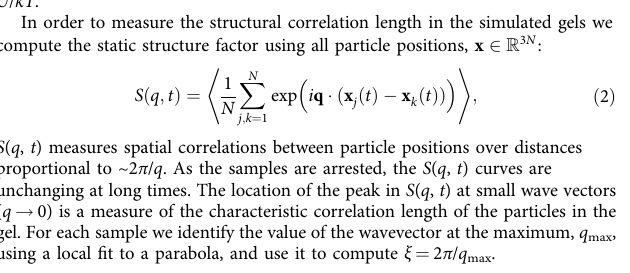
Table 1 Model depletion systems compared in this